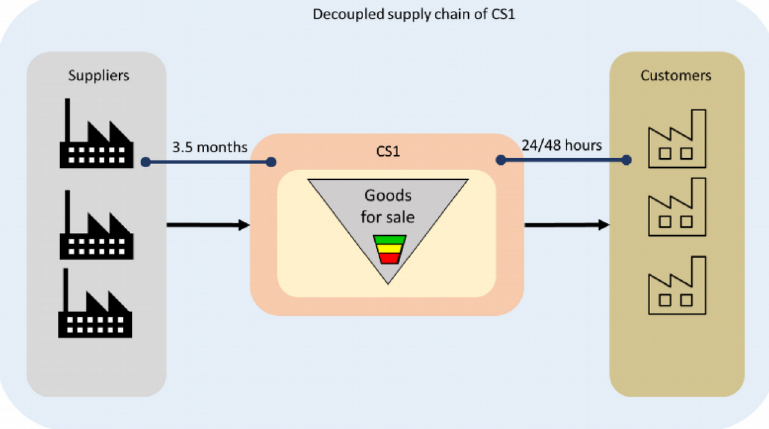
Figure 6. Decoupled supply chain of